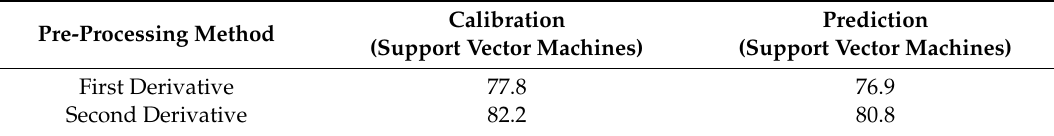
Table 4. Accuracy of the pre-processing methods.